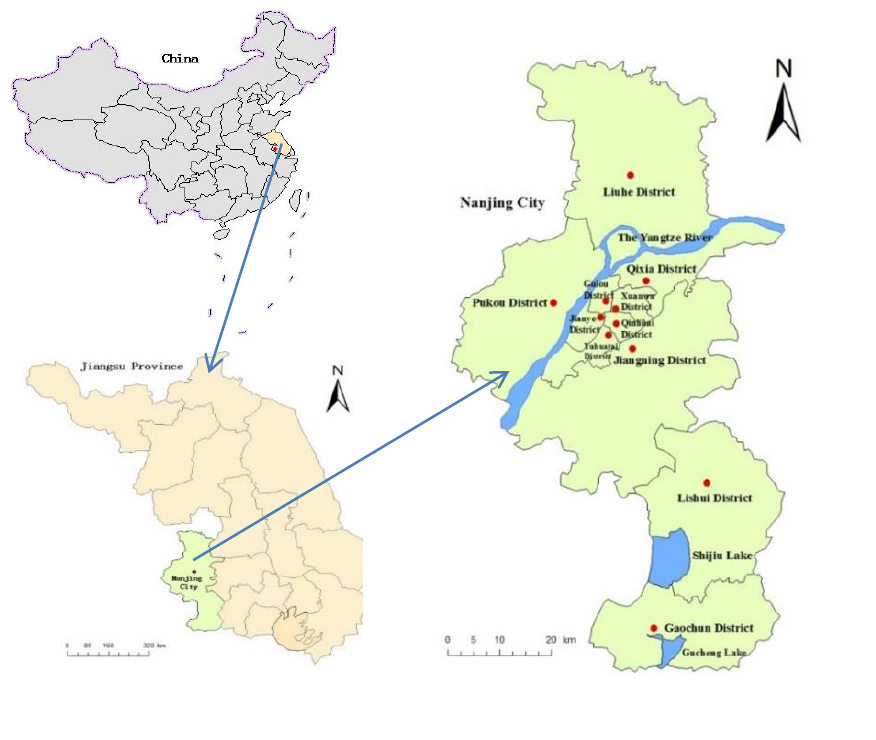
Figure 1. Location and administrative districts of Nanjing in Jiangsu Province,